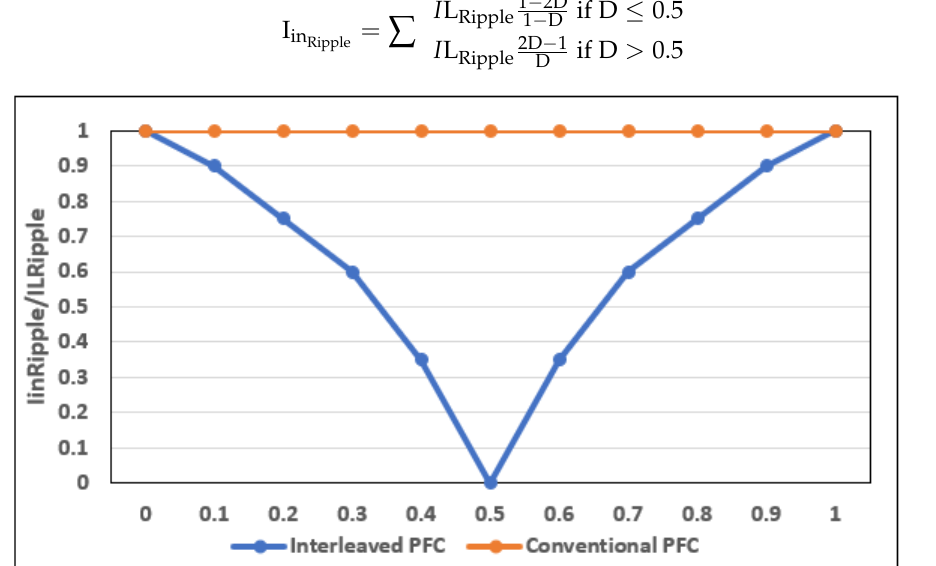
Figure 5. Normalized input ripple current vs. duty cycle in conventional and interleaved PFC.